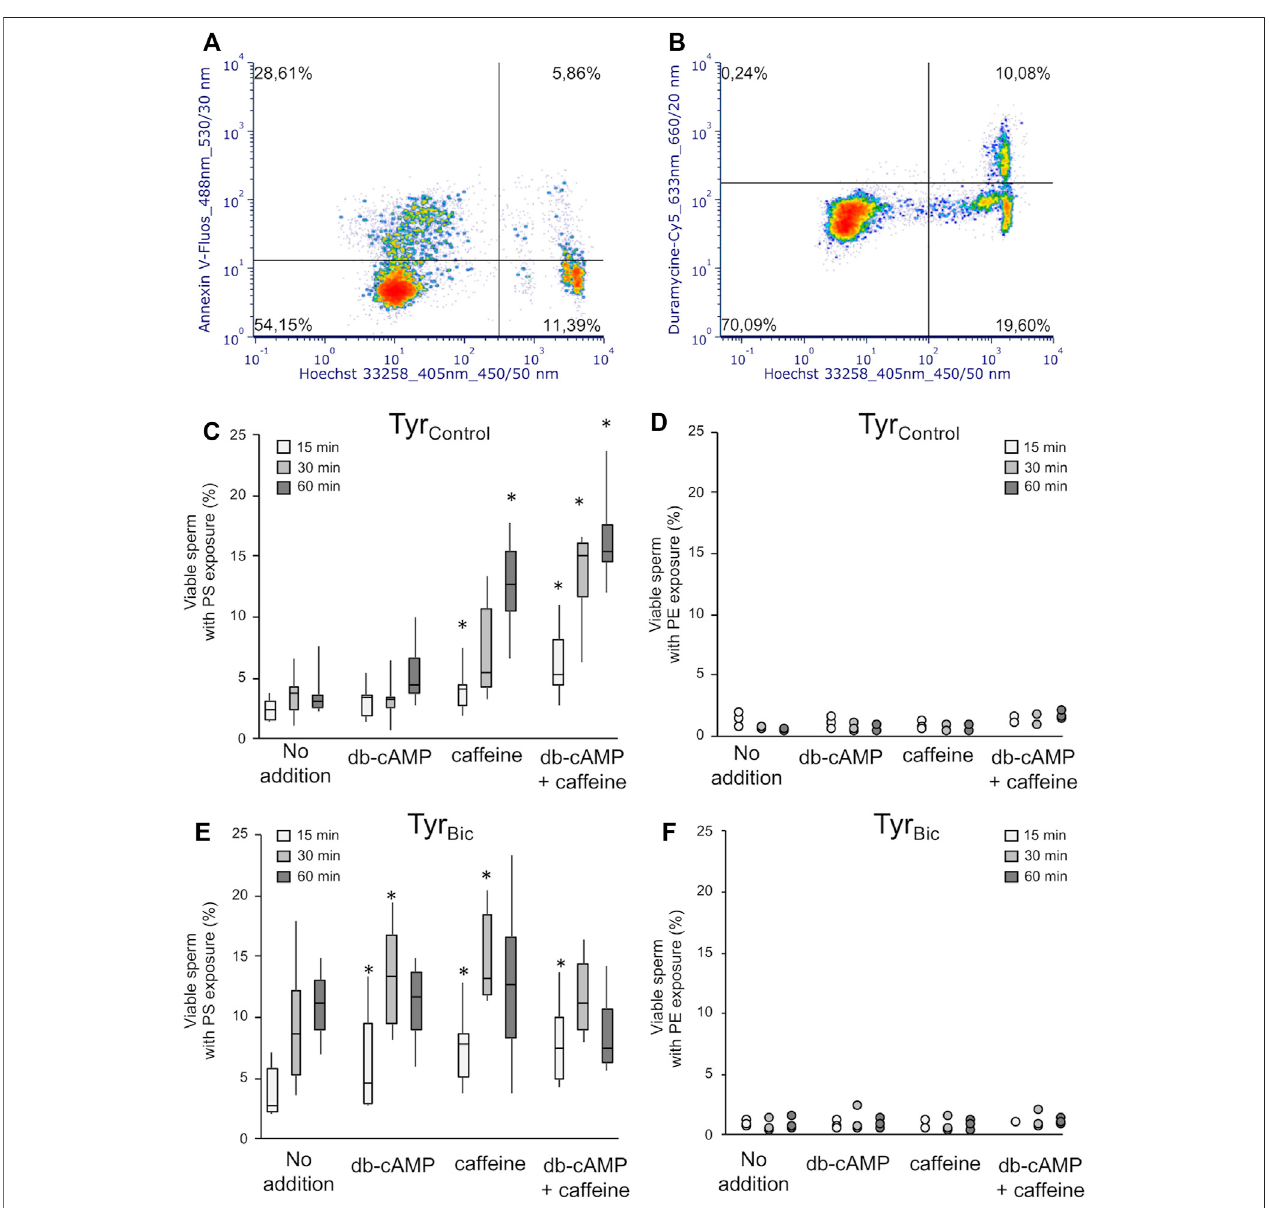
FIGURE 6 | Viable stallion spermatozoa demonstrate exposed PS, but not PE upon direct or indirect elevation of intracellular cAMP levels. Spermatozoa were incubated eitherinthepresence of30 mMbicarbonate (Tyr Bic )or itsabsence(Tyr Control ).Mediacontainedeithernofurtheradditions, 1 mM db-cAMP, 1 mM caffeine,or a combination of 1 mM each of db-cAMP and caffeine. PS exposure to the outer lipid monolayer of the sperm plasma membrane in viable (Hoechst 33258 negative) sperm wasdetectedusingAnnexinV-Fluos[ (A,C,E) ; n (cid:2) 6stallions].Anasterisk(*)indicatessigni fi cantdifferencesbetweensampleswithnoadditionandsamples exposed to db-cAMP and/or caffeine ( p < 0.05). PE exposure residues was monitored using duramycine-Cy5 [ (B,D,F) ; n (cid:2) 3 stallions].